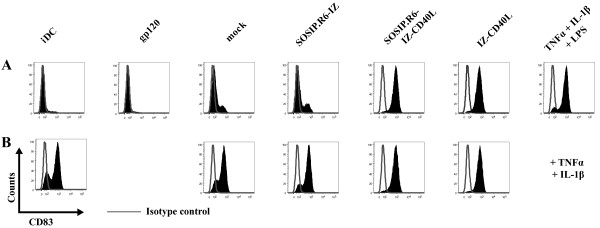
SOSIP.R6-IZ-CD40L induces DC maturation. A. Monocyte-derived iDC were cultured for 48h in the presence of SOSIP.R6-IZ, SOSIP.R6-IZ-CD40L or control stimuli. The expression of the maturation marker CD83 was monitored by FACS. B. CD83 was measured on DC stimulated for 48 h with a combination of TNF-α/IL-1β and SOSIP.R6-IZ, SOSIP.R6-IZ-CD40L or control stimuli. Gray lines represent the isotype-matched control. Cells were double-stained for CD11c and CD83 and CD83 Histograms of cells gated on CD11c are shown (> 25,000 events).